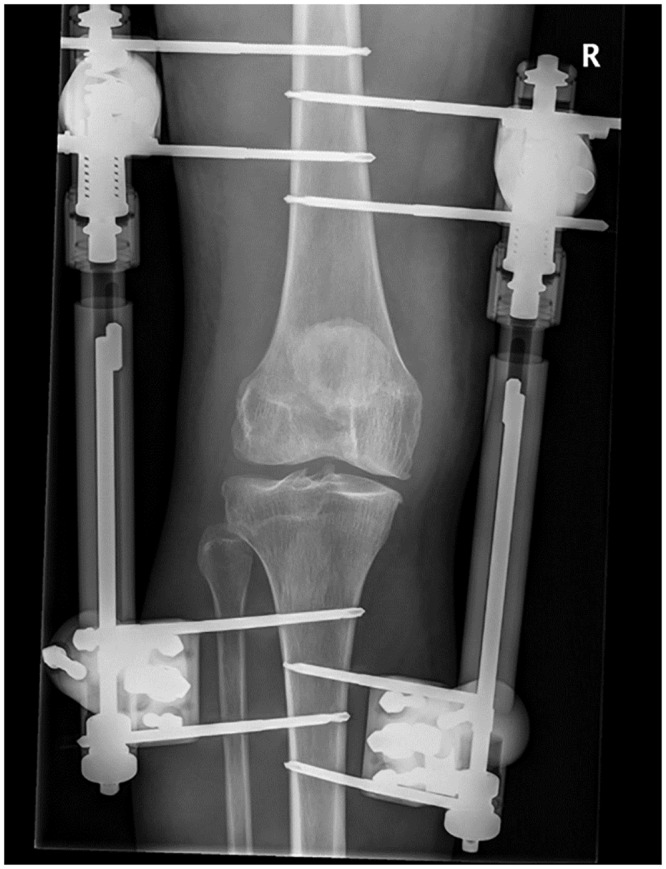
Representative radiograph of the external distraction frame in use.